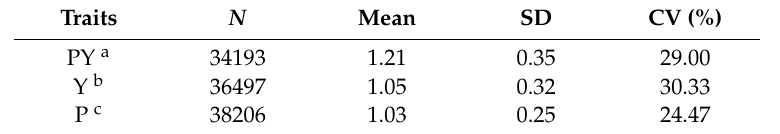
Table 1. Descriptive statistics for PY (kg / day), Y (kg / day) and P (dimensionless) traits in Murciano-Granadina goats.